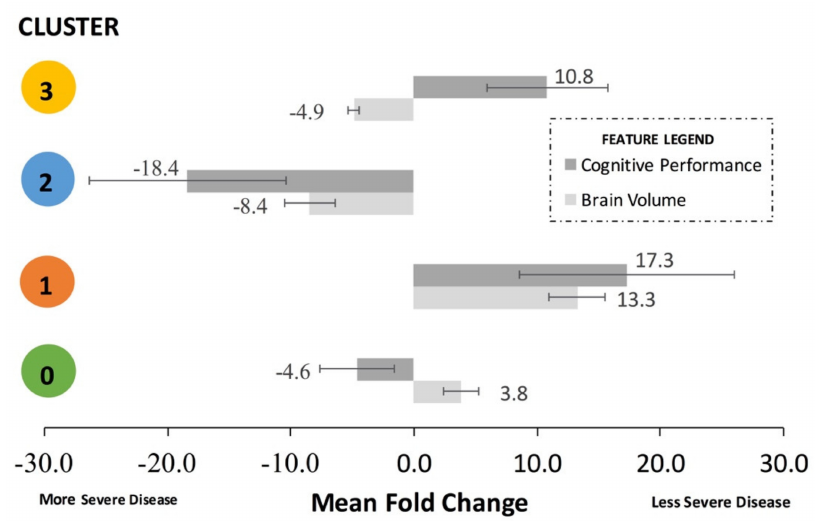
Figure 4. Aggregate standardized trends of brain volume and cognitive performance. Metrics from Table 3 were separated into features measuring brain volume or features measuring cognitive performance. To calculate the represented mean fold change of each cluster, the actual signs of the feature fold changes in Table 3 were subsequently standardized to align with either “less severe disease”, represented by an average positive fold change (higher brain volume or better cognitive performance), or “more severe disease”, represented by a negative fold change (lower brain volume or worse cognitive performance). Error bars represent the standard deviation of the standardized mean fold change of the cluster compared to the whole dataset. Cluster 1 had the least severe disease (highest brain volume and best cognitive performance), whereas cluster 2 had the most severe disease (lowest brain volume and worst cognitive performance). Clusters 0 and 3 represent different mid-severity sub-populations. Cluster 0 had relatively higher brain volume but relatively worse cognitive performance, whereas cluster 3 had better cognitive performance but lesser brain